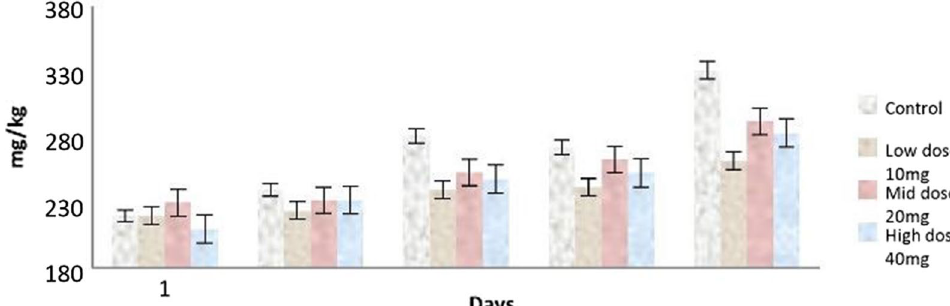
Fig. 5 Changes of Wistar albino rat’s body weight exposed to